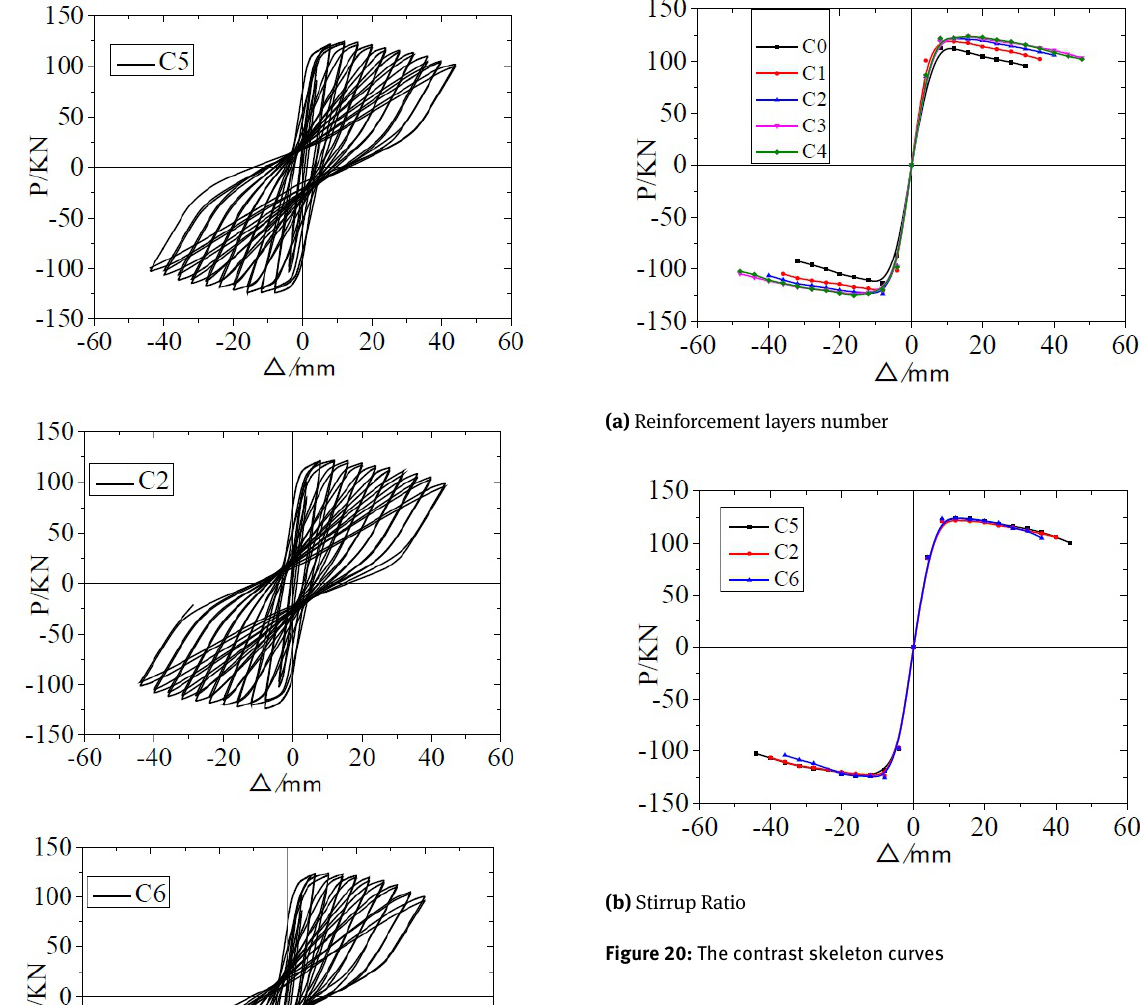
the range of 1 to 3 layers of textile grid layout can effec- tively improve the energy dissipation capacity of compo- nents, and it increases with an increase of the number of reinforcement layers, but the increase of energy dissipa- tion capacity is limited when the number of textile grid layout layers is increased. From the aspect of energy dissi- pation rate, the unstrengthened column and the strength- ened column are largely the same before and after reach- ing the yield point, which is consistent with the stiffness degradation law. However, in the later stage of displace- ment loading, the energy dissipation rate of the strength- enedcolumnincreases,andtheroleofTRCisfullyutilized. As the number of layers of textile grid increases, the rate of energy dissipation of the specimen increases slightly, but the increase is not obvious. (2) Influence of Stirrup Ratio on TRC Columns The energy dissipation curves of specimens with dif- ferent stirrup spacing are shown in Fig. 22(b). The accumu- lated energy dissipation of C2 and C5 increased by